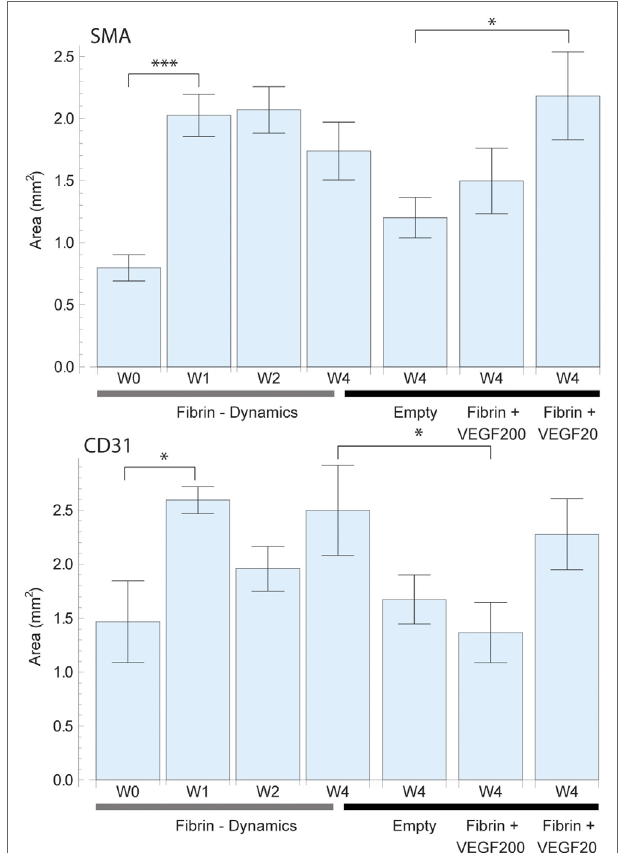
FIGURe 5 | Total perfused area based on a virtual perfusion distance of oxygen which was defined as 150 µm around each vessel for smooth muscle actin (SMA) (top) and CD31 (bottom) staining. The perfused area was calculated by expanding adding up each vessel cross section by 150 µm. Overlapping areas were single counted. The left 4 bars indicate the change in perfused area in pure fibrin over a period of 4 weeks. There was an initially strong increase in vascularized area which then remained constant. The right 4 bars indicate the effect of high dose (200 ng) and low dose (20 ng) recombinant human vascular endothelial growth factor (rhVEGF165) in a fibrin matrix in comparison to pure fibrin and no matrix. The positive effects of fibrin and rhVEGF165 as well as missing effect of excessive rhVEGF165 dosings are confirmed once more.